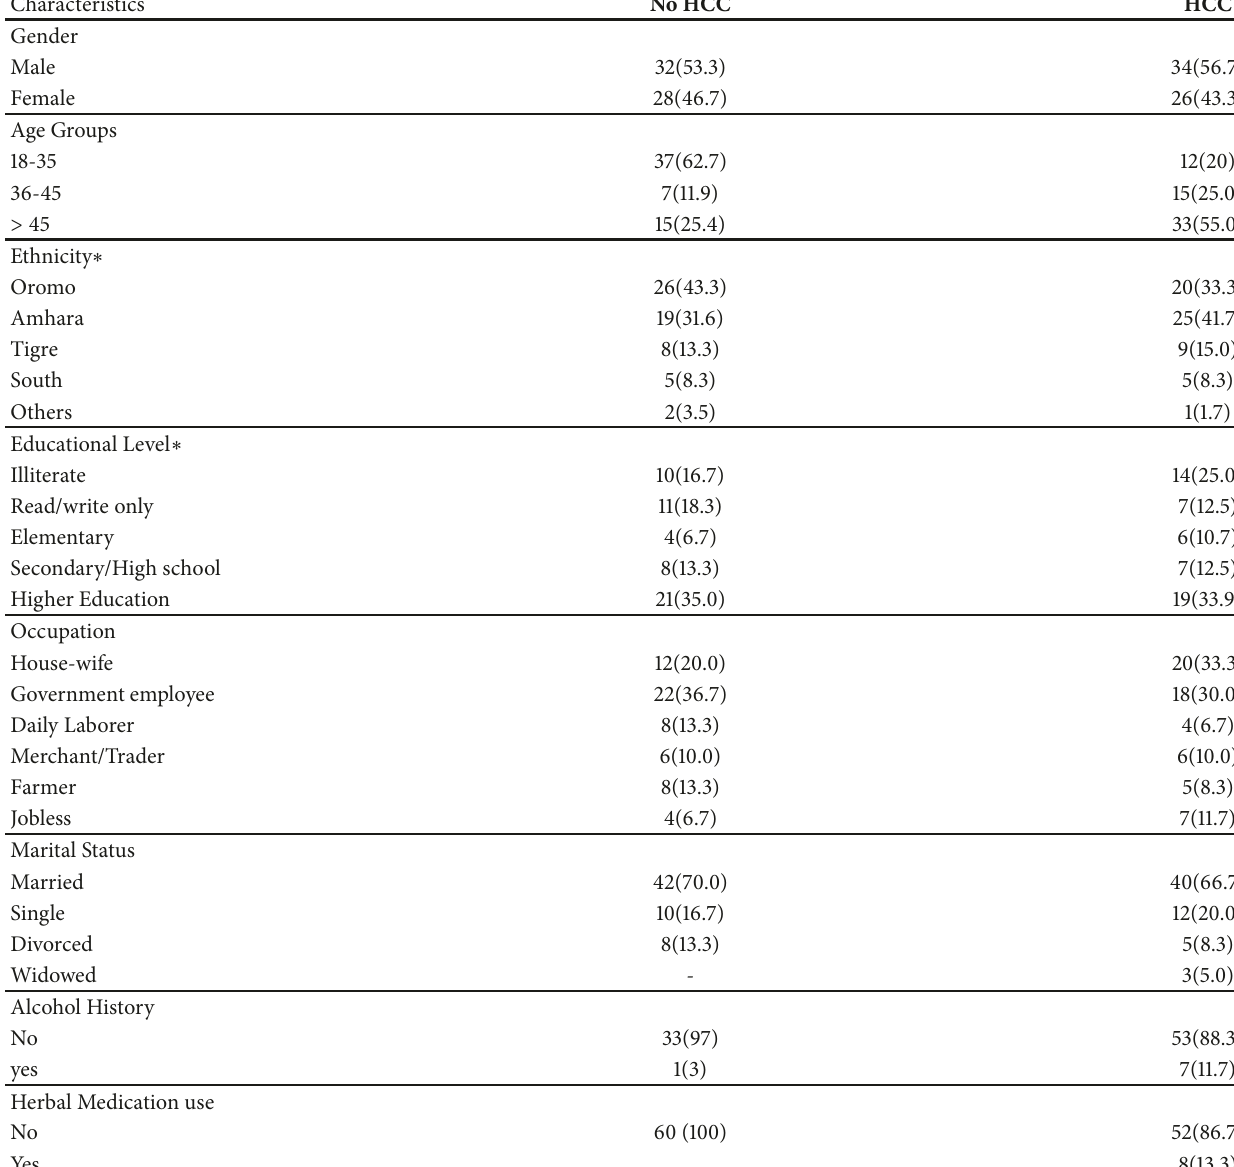
Table 1: Baseline characteristics of patients diagnosed with HCC and controls